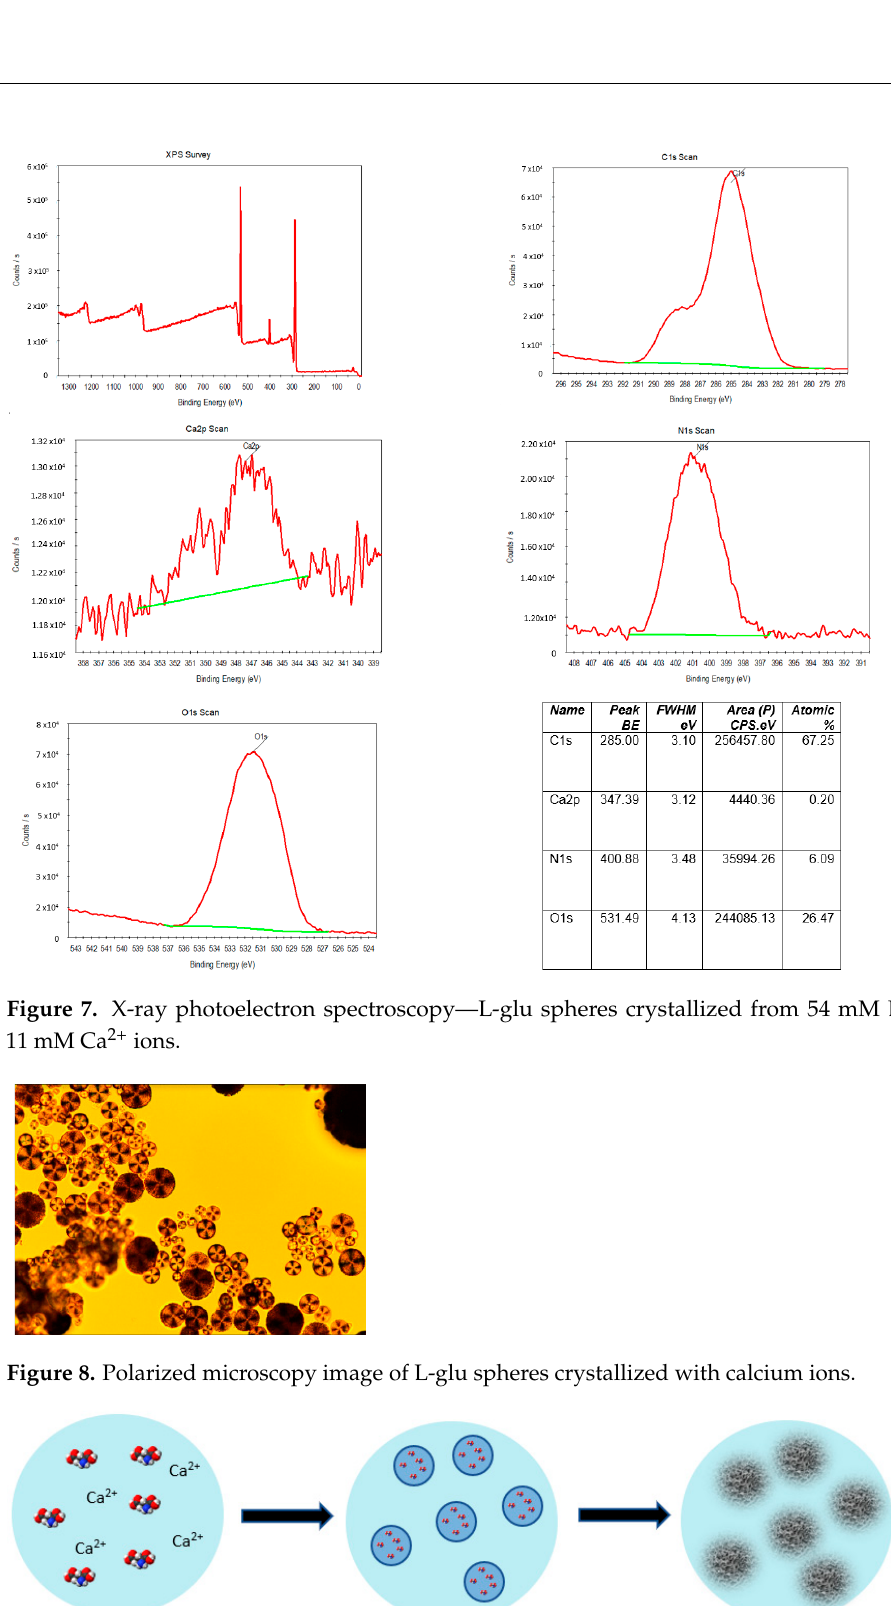
Figure 8. Polarized microscopy image of L-glu spheres crystallized with calcium ions.